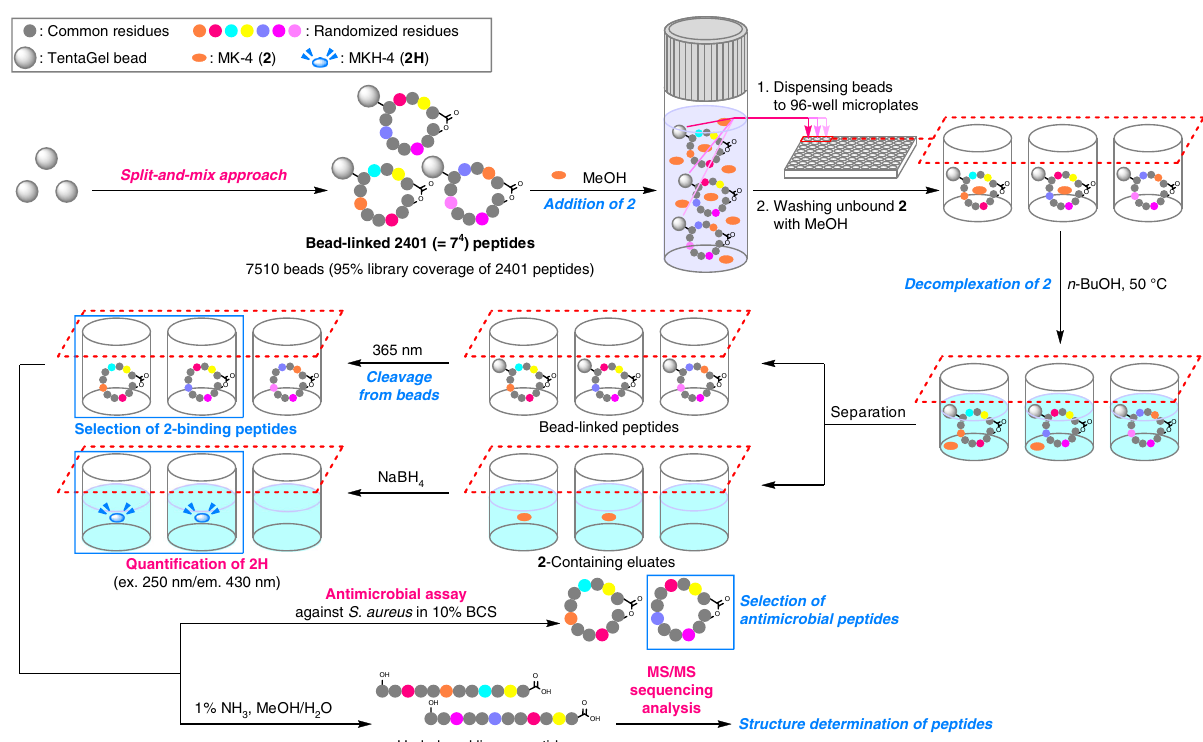
Fig. 3 Overview of the OBOC strategy. A high throughput platform for constructing and screening 2401 lysocin E analogues is